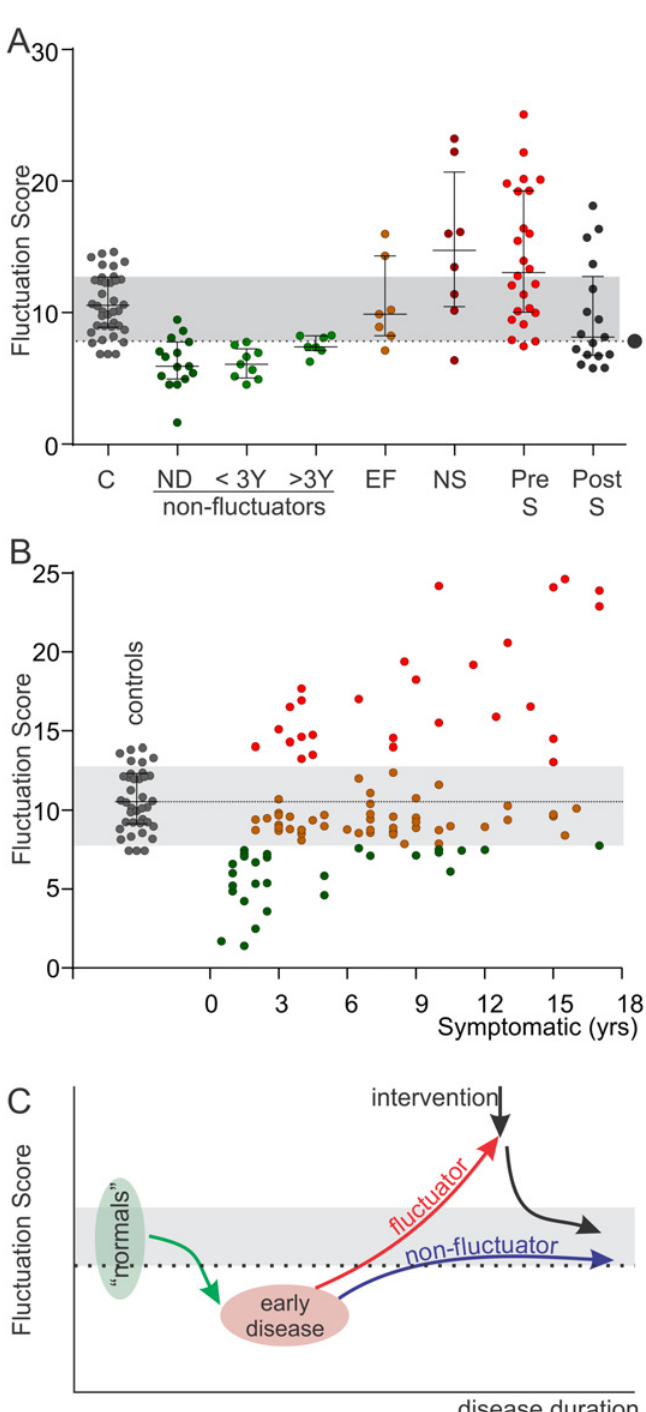
Fig 4. The change in Fluctuation Score with disease progression. A: The Fluctuation Score of subjects described by the following captions were plotted. C: Control subjects (grey dots). ND: people with PD who were newly diagnosed (green dots). < 3Y: non fluctuators with disease duration less than 3 years, (green dots). > 3Y: non fluctuators with disease duration more than 3 years ( > 3Y) (green dots), EF: “ early ” fluctuators (EF) meaning modest non troublesome fluctuations (brown dots), NS: fluctuators but not suitable (NS) for DBS (dark red dots), PRE-S: on the waiting list for DBS (crimson red dots). POST-S: Post DBS (black dots). The dotted line with a black circle is the FS scores that separates fluctuators and non-fluctuators (the FT) and